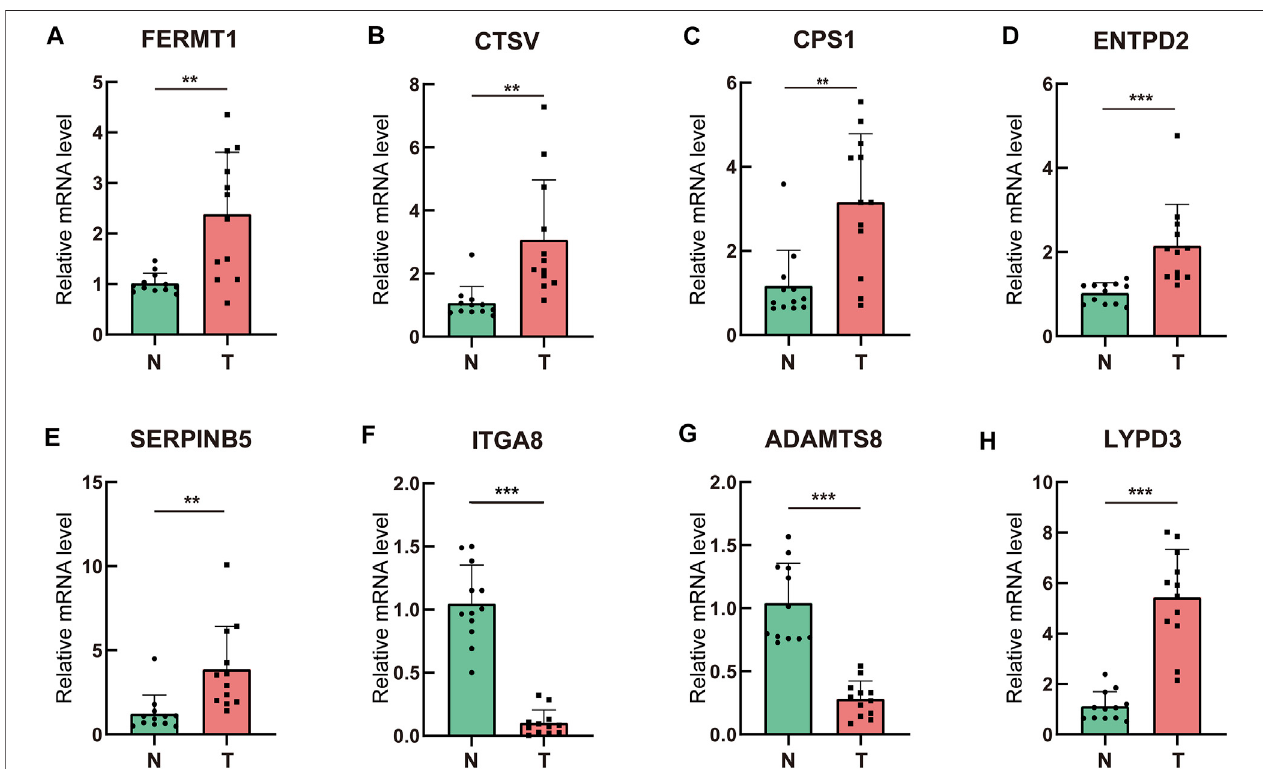
FIGURE 10 | Validation of the prognostic ERGs in clinical specimens by qRT-PCR (A – H) Differential expression of the prognostic ERGs between lung adenocarcinoma tissues and paired adjacent normal lung tissues.ERGs = extracellular matrix-related genes; * p < 0.05; ** p < 0.01; *** p < 0.001.